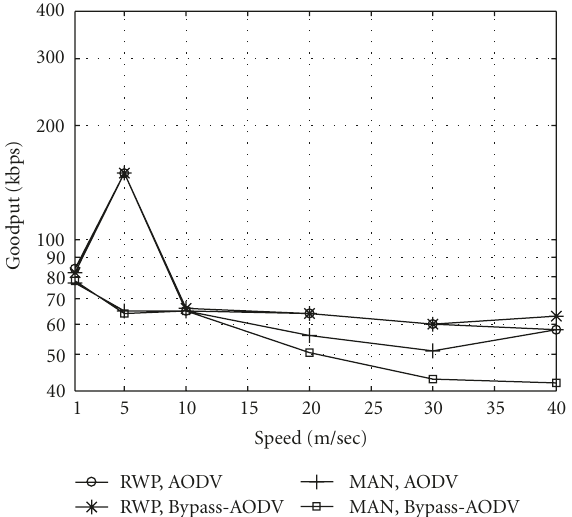
Figure 14: Goodput, Bypass-AODV, and AODV routing protocols.